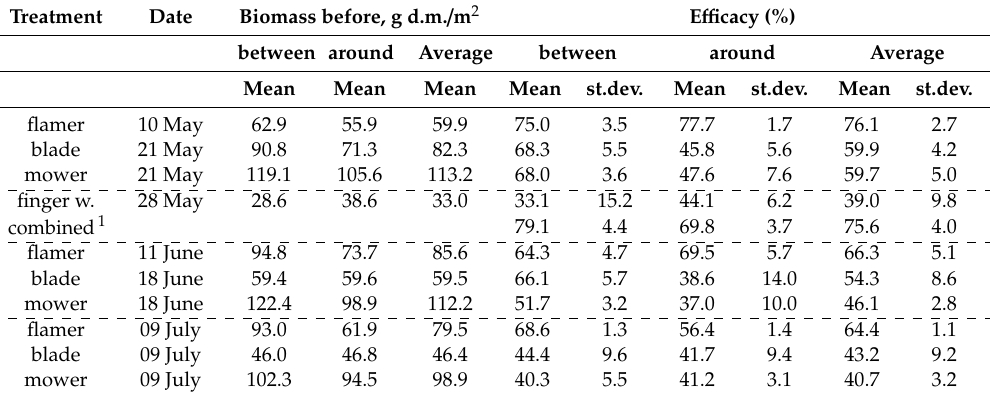
Table 2. Weed biomass before application, and e ffi cacy of weed removal (mean and standard